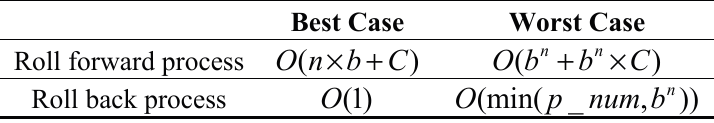
Table 2. The complexity for our proposed